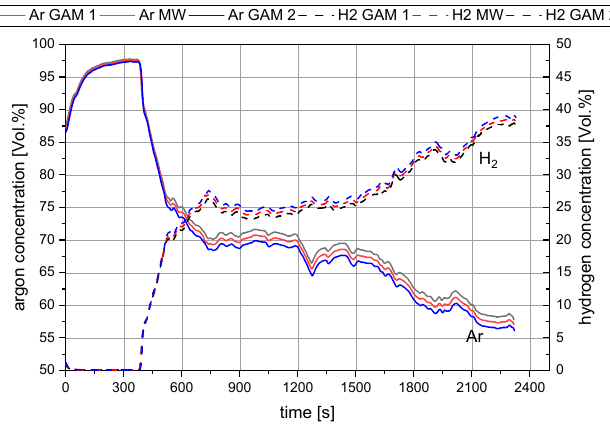
Figure 6. Evaluation for the mean values of trail B50/C1.16.